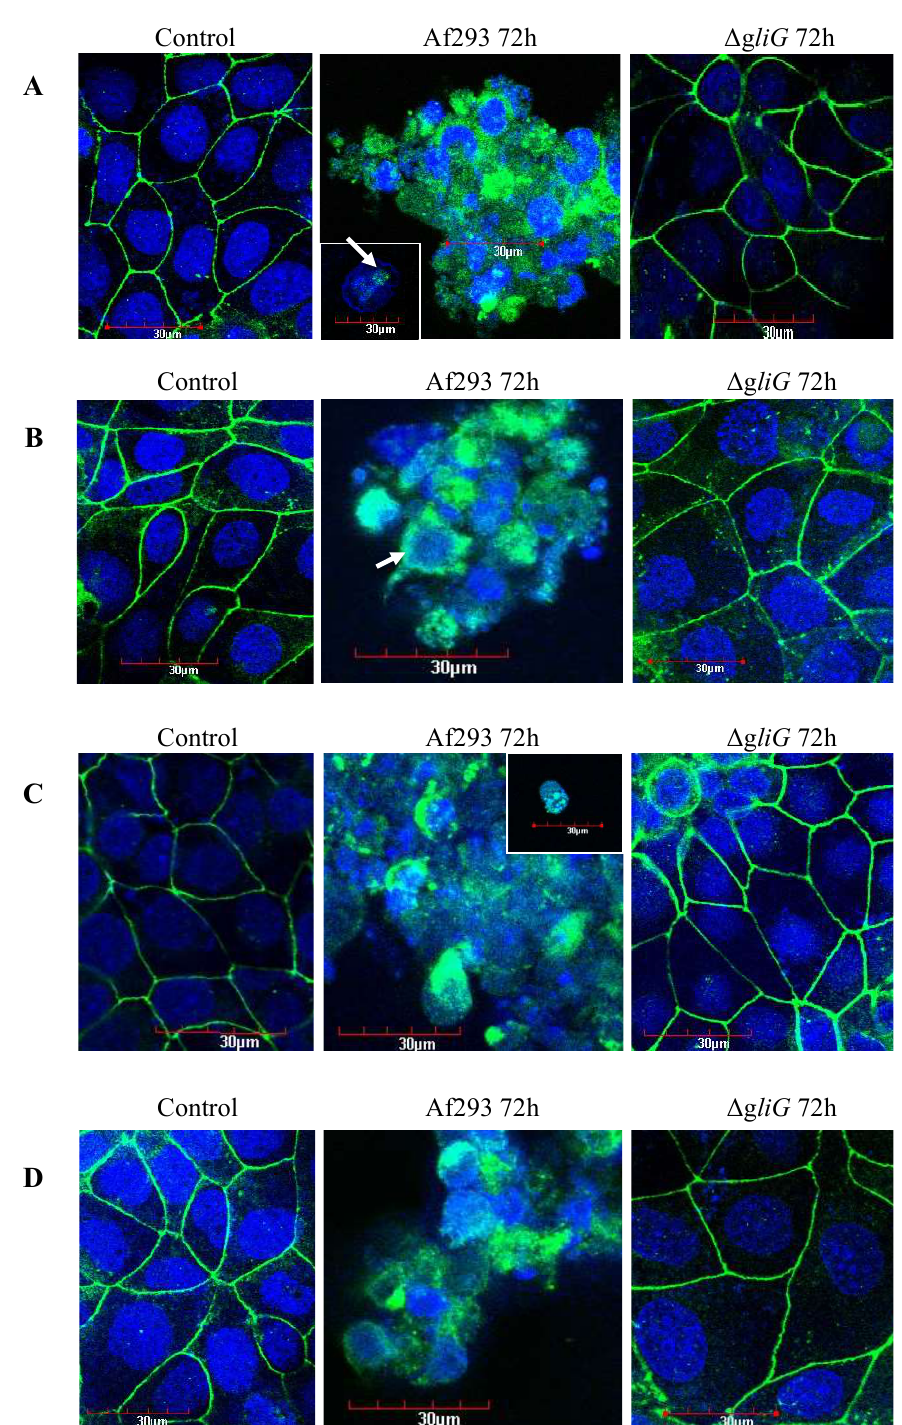
Figure 4. JAM-A and ZO-1 distribution in CFBE and HBE monolayers exposed to 72h supernatants of Af293 and ∆ gliG . Confocal images at × 600 of ( A ) ZO-1 distribution and ( B ) JAM-A distribution in CFBE monolayers and ( C ) ZO-1 distribution and ( D ) JAM-A distribution in HBE monolayers follow- ing 24 h exposure to MEM media alone (control), 72 h supernatant of Af293 and 72 h supernatant of ∆ gliG . ZO-1 and JAM-A were immunostained with FITC-conjugated anti-JAM-A and anti-ZO-1 antibodies (green). Monolayers were counterstained with DAPI to visualise the nucleus of the cells (blue). White arrows depicts abnormal distribution of ZO-1 and JAM-A within the cell cytoplasm. Scale bar indicates 30 µ